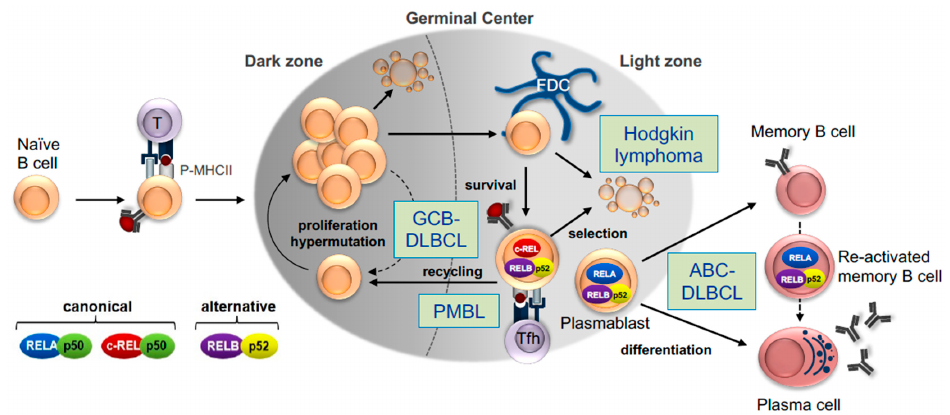
Figure 2. Germinal center B-cell development, NF- κ B transcription factors and putative cellular derivation of GC lymphomas. Schematics of the major GC B-cell developmental stages, with critical NF- κ B transcription factor subunits involved in the reaction. The memory B-cell re-activation step is also shown. Boxes indicate the putative relation of GC-derived B-cell lymphomas to their normal cellular counterparts. NF- κ B c-REL and the RELB/p52 heterodimer are independently required for the recirculation of light zone B cells to the dark zone, i.e., the population that presumably gives rise to GCB-DLBCL, suggesting that these transcription factors may play a role in the pathogenesis of GCB-DLBCL and potentially PMBL. NF- κ B RELA is required for plasmablastic development, which is associated with the ABC-DLBCL cell-of-origin, suggesting a possible role for RELA in ABC- DLBCL lymphomagenesis. cHL is thought to originate from the transformation of GC B cells with crippled Ig variable region genes that would normally apoptose. Tfh, T follicular helper cell. FDC, follicular dendritic cell; P-MHCII, peptide-MHC class II complex.